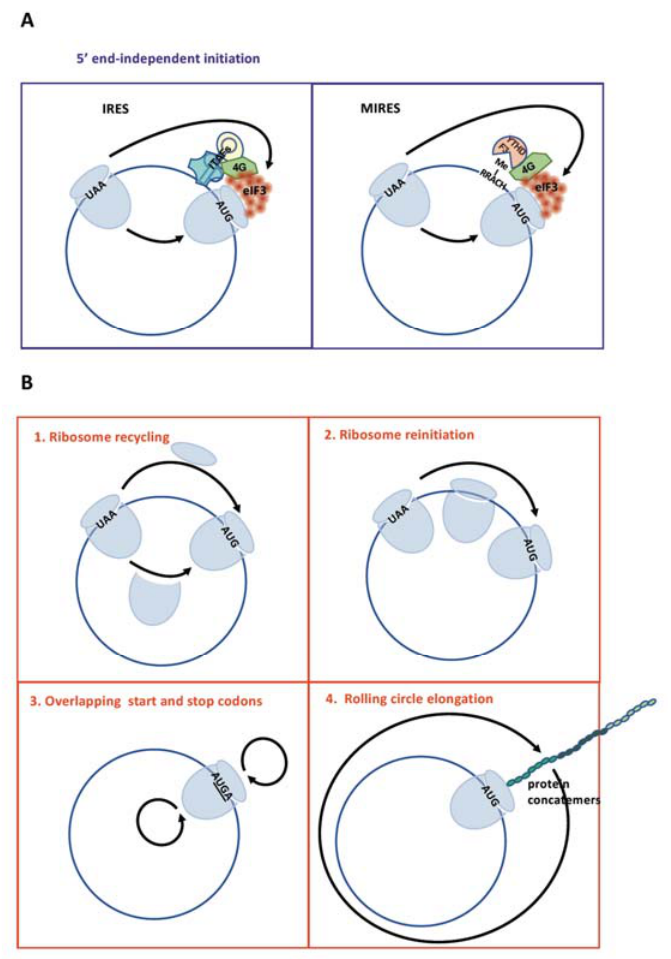
Figure 1. Translation of circular RNAs (circRNAs) . ( A ). Translation initiation on circRNAs by internal ribosome entry sites (IRESs) ( left ) and m 6 A-induced ribosome engagement sites (MIRESs) ( right ) is schematized with the main proteins involved in the complexes. Details are provided in the text (Sections 4 and 5). ( B ). Mechanisms of translation elongation on circRNAs: even though 5 (cid:48) end-independent initiation may be less e ffi cient than cap-dependent initiation, translation e ffi ciency is enhanced through ribosome recycling ( 1 ), reinitiation ( 2 ), overlapping start and stop codons ( 3 ) or rolling-circle elongation ( 4 ). Details are provided in the text (Section